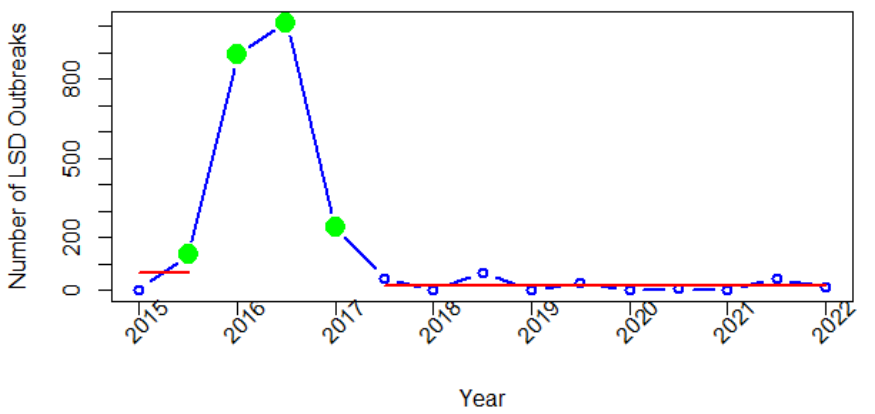
Figure 6. Change points in time series of LSD outbreak reports in Europe. Green dots are change points, and red lines are corresponding segments.